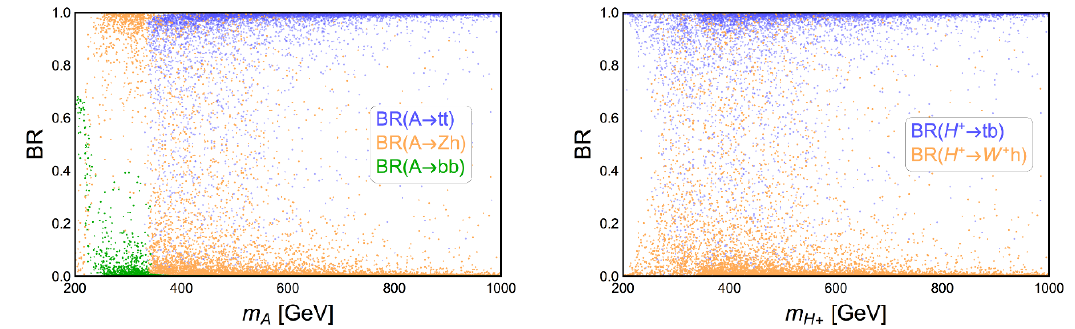
Figure 16 . (Left) The BRs of the A state in the t (cid:22) t (blue), Zh (orange) and bb (green) channels. (Right) The BRs of the charged Higgs in the tb (blue) and Wh (orange)